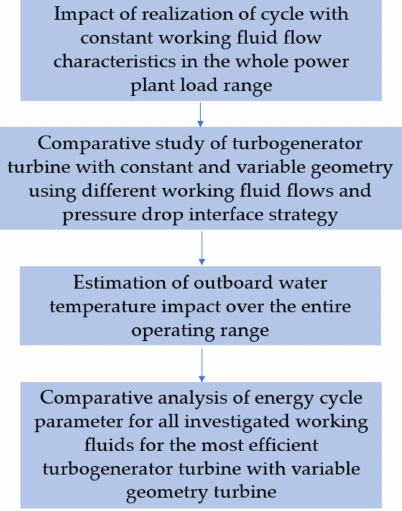
Figure 1. Logical sequence of comparative research plan.